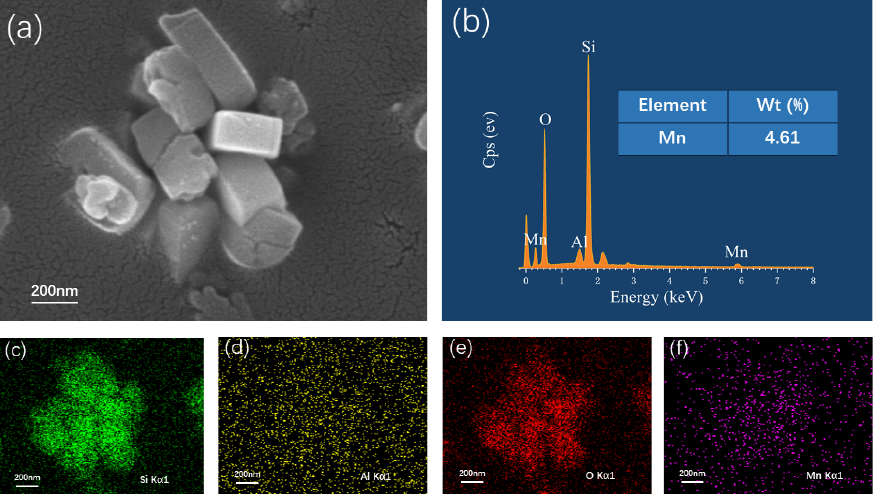
Figure 7. ( a ) SEM images, ( b ) quantitative analyses, and EDS elemental mappings of ( c ) Si, ( d ) Al, ( e ) O, ( f ) Mn over Mn/ZSM ‐ 5 ‐ N catalyst. ( e ) O, ( f ) Mn over Mn/ZSM-5-N